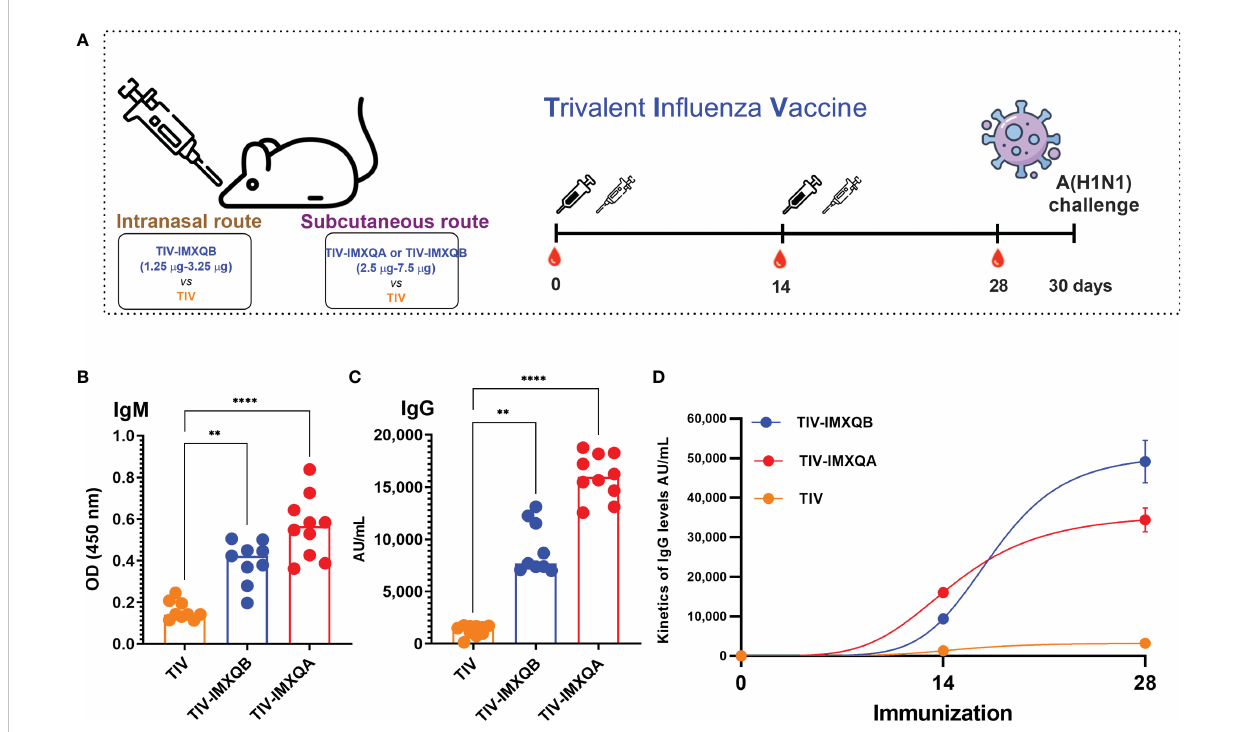
FIGURE 2 Two doses of subcutaneous (s.c.) injection of an adjuvanted in fl uenza vaccine (TIV-IMXQB) augment the antibody response of commercial trivalent in fl uenza vaccines (TIVs) in mice. (A) Schematic vaccination schedule. Female BALB/c mice were vaccinated by the s.c. route on days 0 (priming) and 14 (booster) with either TIV-IMXQB, the TIV-IMXQA-adjuvanted formulation, or TIV alone (commercial vaccine), and antibody levels were measured in sera on day 28. (B) Speci fi c anti-TIV IgM levels 14 days post priming. (C) IgG antibody levels. (D) Total IgG kinetics (days 14 and 28)). The median value is indicated by a line, and the dots indicate individual values. The statistical analyses were performed using Kruskal – Wallis and uncorrected Dunn ’ s post hoc test, comparing every group against the unadjuvanted (TIV alone) group as control. Statistically signi fi cant differences are indicated: ** p < 0.01 and **** p<